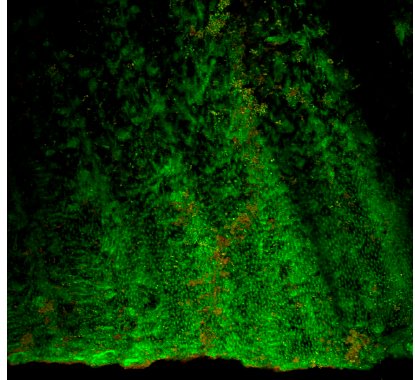
Figure 3. Confocal laser scanning microscopic (CLSM) image (single slice at 20× magnification) of a 1 week biofilm of Enterococcus fecalis within the root canal. Dense aggregates of bacteria are seen within the dentinal tubules. The advantage of CLSM imaging is to detect the presence of apparently dead (red) and apparently live (green) bacteria. It is also possible to perform 3 dimensional reconstruction of Z-stack images to study biofilm architecture.